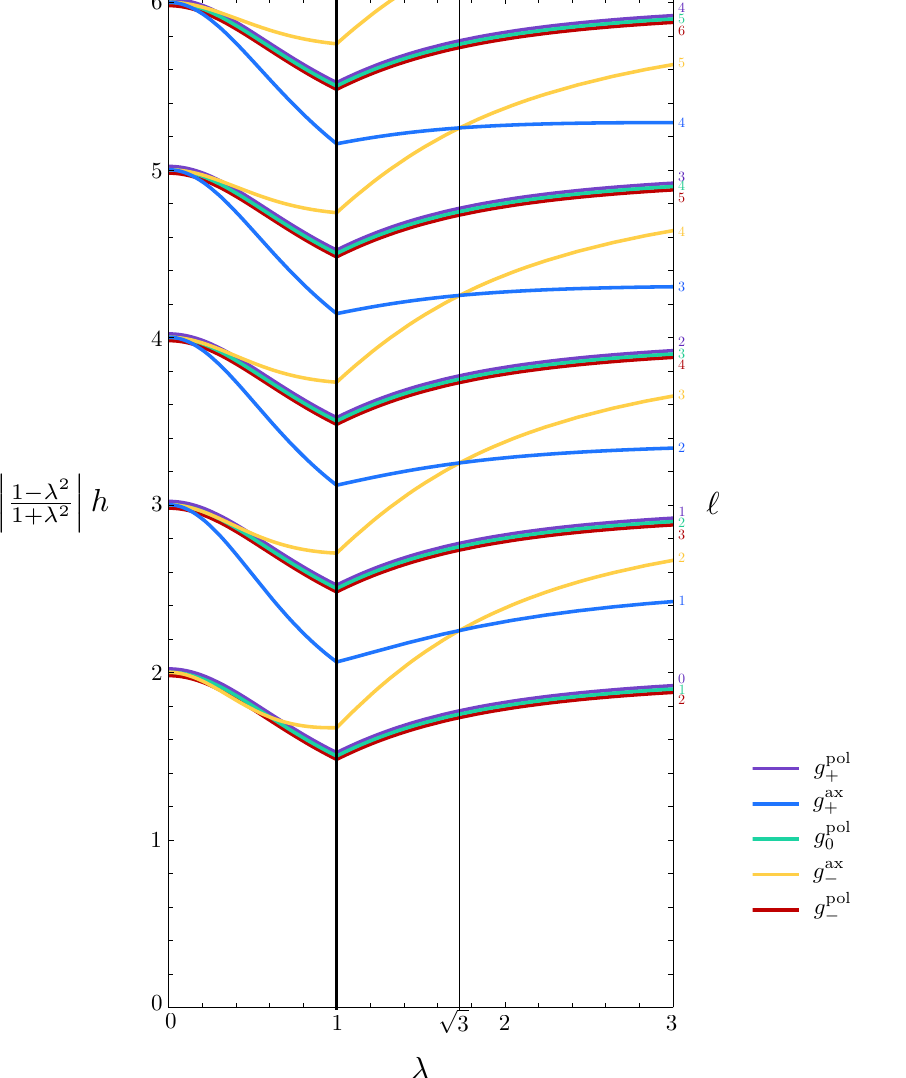
Figure 2 . Spectrum of perturbations around the AdS 2 × S 2 string-frame solution (2.5) in Einstein- Maxwell-dilaton theory. The conformal effective potential g/z 2 corresponds to an effective mass term (3.3). For general dilaton coupling λ , we find five towers of massive states, indexed by angular momentum ‘ ≥ 2 , while we find one state for ‘ = 0 and three for ‘ = 1 . The couplings g , given in eq. (3.4), are recast as a conformal weight h via eq. (3.5) and plotted above for various values of λ , with the corresponding ‘ value given at